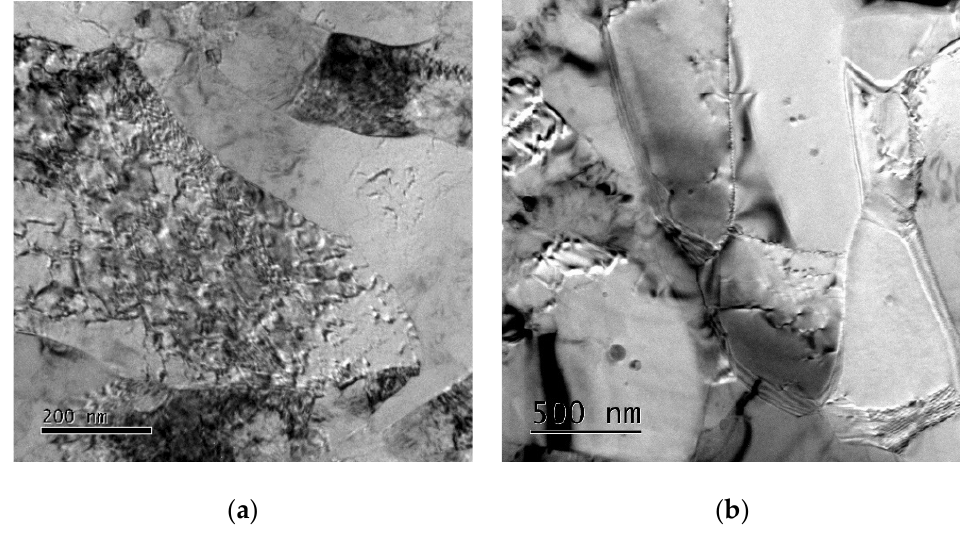
Figure 4. Substructures of: Sample 1a ( a ); Sample 1b ( b ).